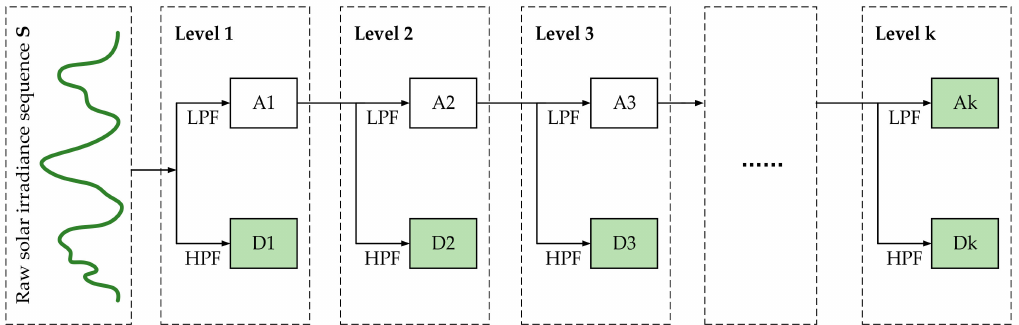
Figure 3. The detailed process of k-level wavelet decomposition. A1 to Ak are the approximate subsequences, and D1 to Dk are the detailed subsequences. All of these subsequences can be forecasted individually using some kind of time sequence forecasting